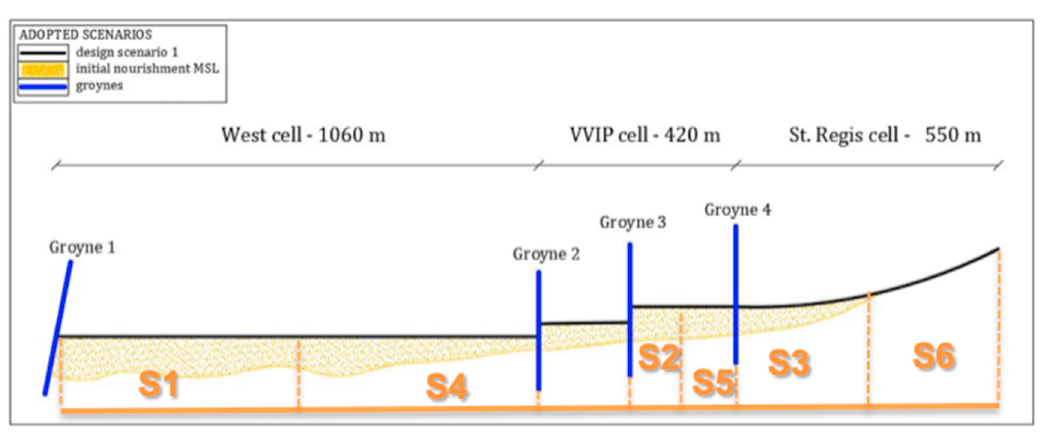
Figure 4. Schematic initial design scenario. Indicated are also the reference sectors for the computation of the maximum accretion / erosion along the